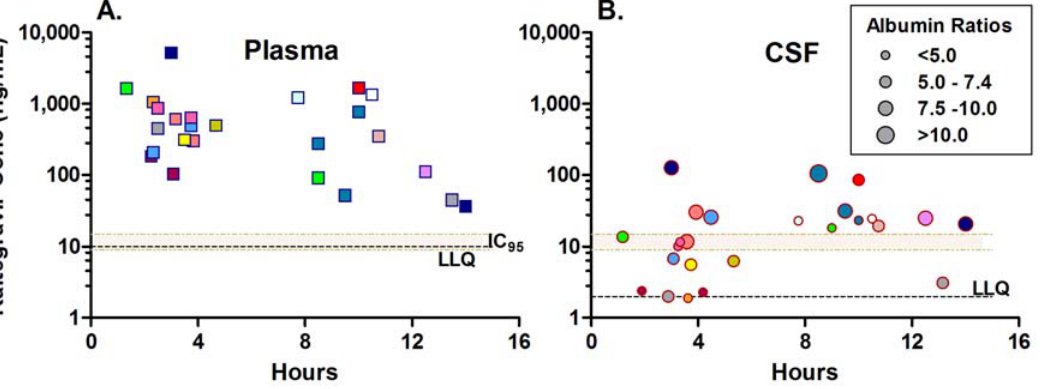
Figure 1. Raltegravir concentrations in plasma (A) and CSF (B) in relation to the time after the previous dose. Results for individual subject evaluations and repeat subject evaluations are indicated by the matching color of squares (plasma) and circles (CSF) coded for each subject. A: The horizontal grey fill plots IC 95 range of 9.0–15.0 ng/ml, while the lower dashed horizontal line within this zone shows the lower limit of quantitation (LLQ) for plasma of 10.0 ng/ml. B: The one CSF measurement of raltegravir below the LLQ is plotted as if equal to 1.9 ng/ml (orange circle). The size of the symbols in B. also varies with the CSF:albumin ratios at the time of sampling as shown by the grey circles in the key: the largest circles show the one sample with ratio . 10, the next largest the 5 samples for albumin ratios from 7.5–10, the next the 10 samples with ratios from 5– 7.4, and the smallest the 9 samples for ratios , 5. The dashed horizontal line within this zone shows the LLQ for CSF of 2.0 ng/ml.